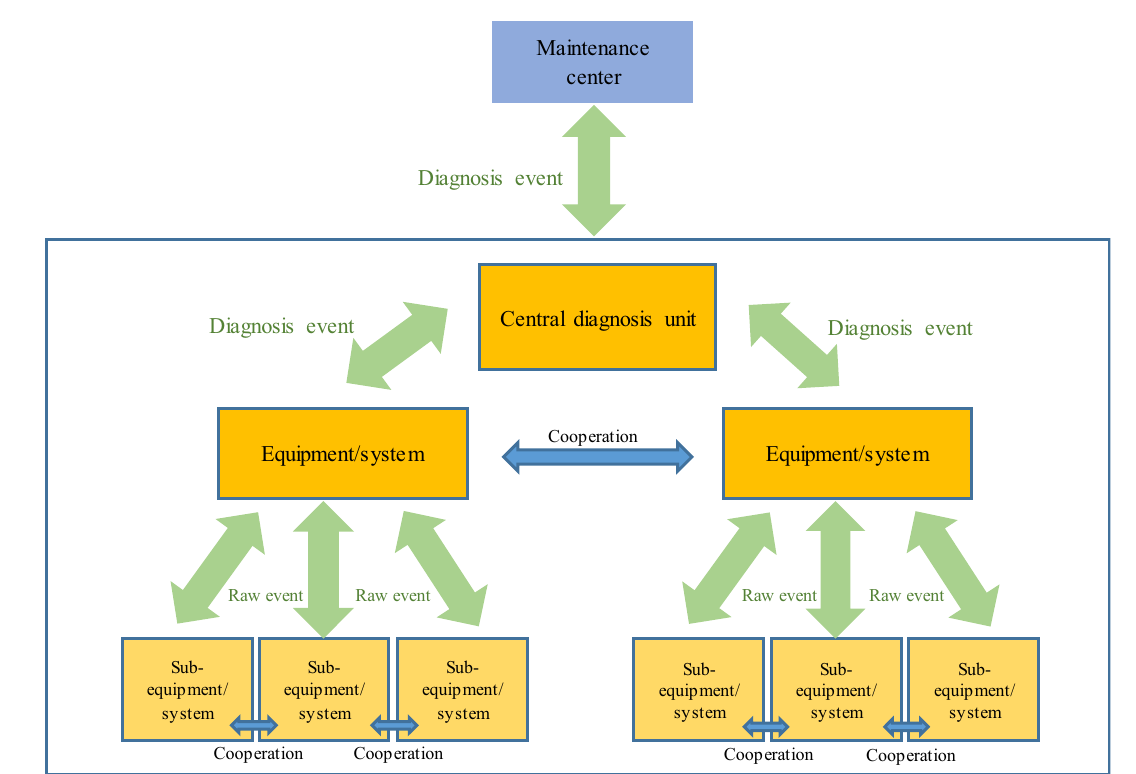
Fig. 5 Decentralized and cooperative fleet